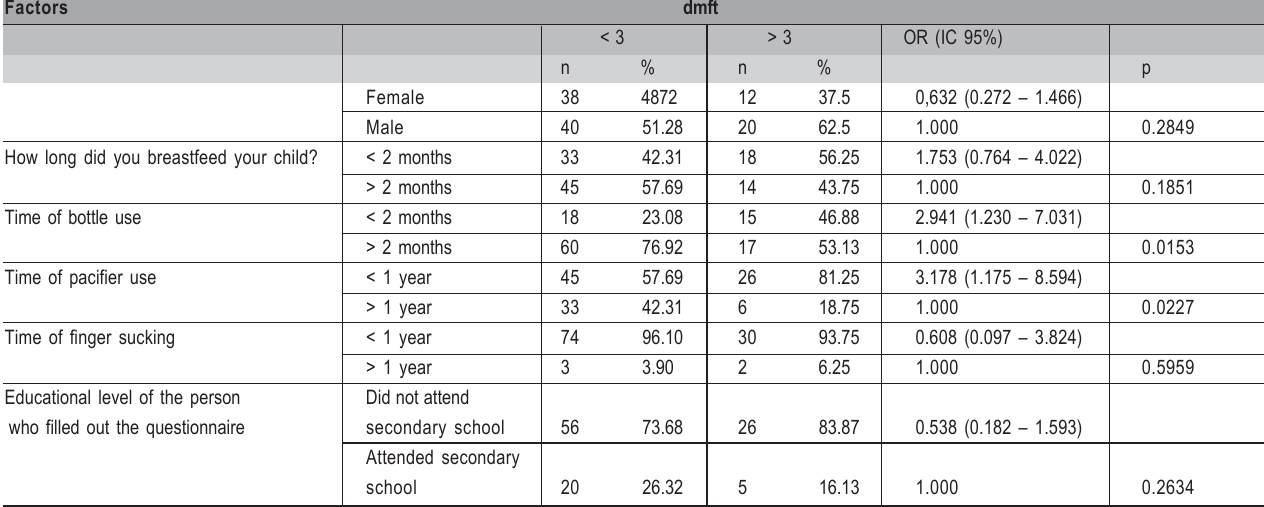
Table 4. Frequency and percentage of the number of